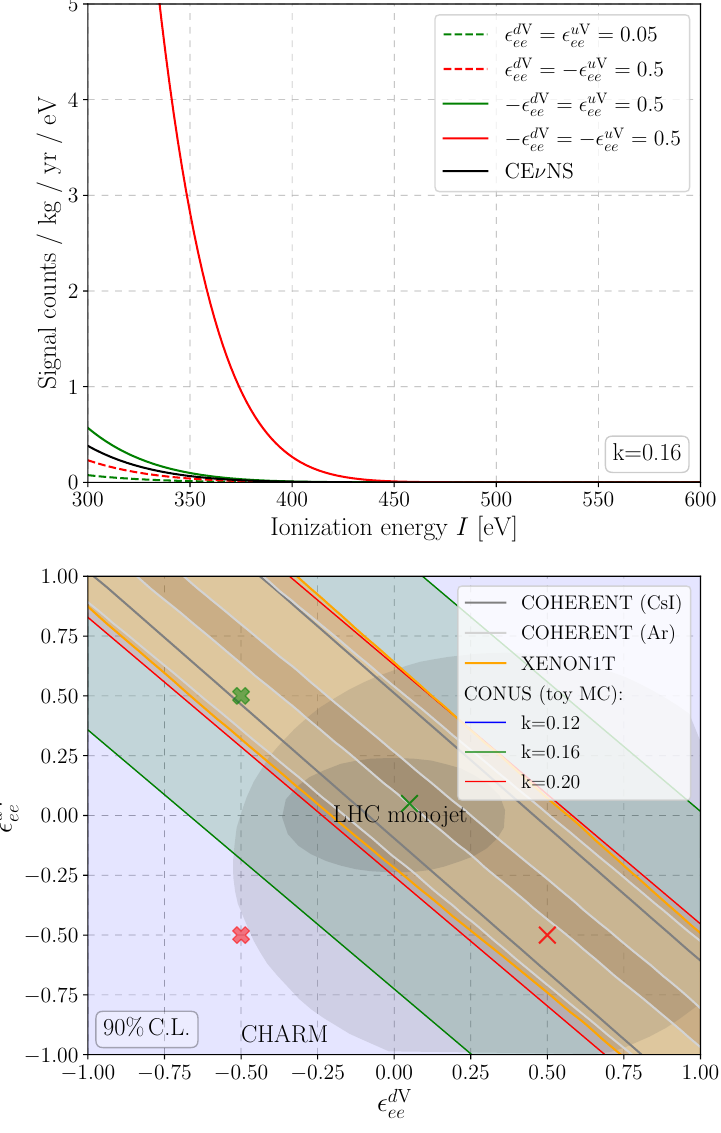
Figure 4 . Top: expected vector NSI signals in detector C1, assuming a quenching parameter of k = 0 . 16 and different coupling values from all quadrants in comparison to the standard CE ν NS signal. Note that, depending on the explicit couplings, destructive interference between the vector NSIs and the SM signals is possible and the expected number of events can be reduced (with respect to the pure SM case). Bottom: allowed regions (at 90% C.L.) of vector NSI couplings (cid:15) u V and (cid:15) d V deduced from the Run -1 Conus data set. As in figure 3, the example points of the ee ee upper plot are marked with crosses, where bold crosses indicate signals stronger than the SM expectation and normal crosses point to the parameter space of destructive interference between the SM and BSM channels. For comparison, constraints (90% C.L.) obtained from Coherent (CsI [10] and Ar [5]) data and the Xenon1T experiment [136] are shown. Further existing limits, e.g. from Charm (90% C.L.) [137] and Lhc monojet searches (95% C.L.) [138] are indicated with grey elliptic